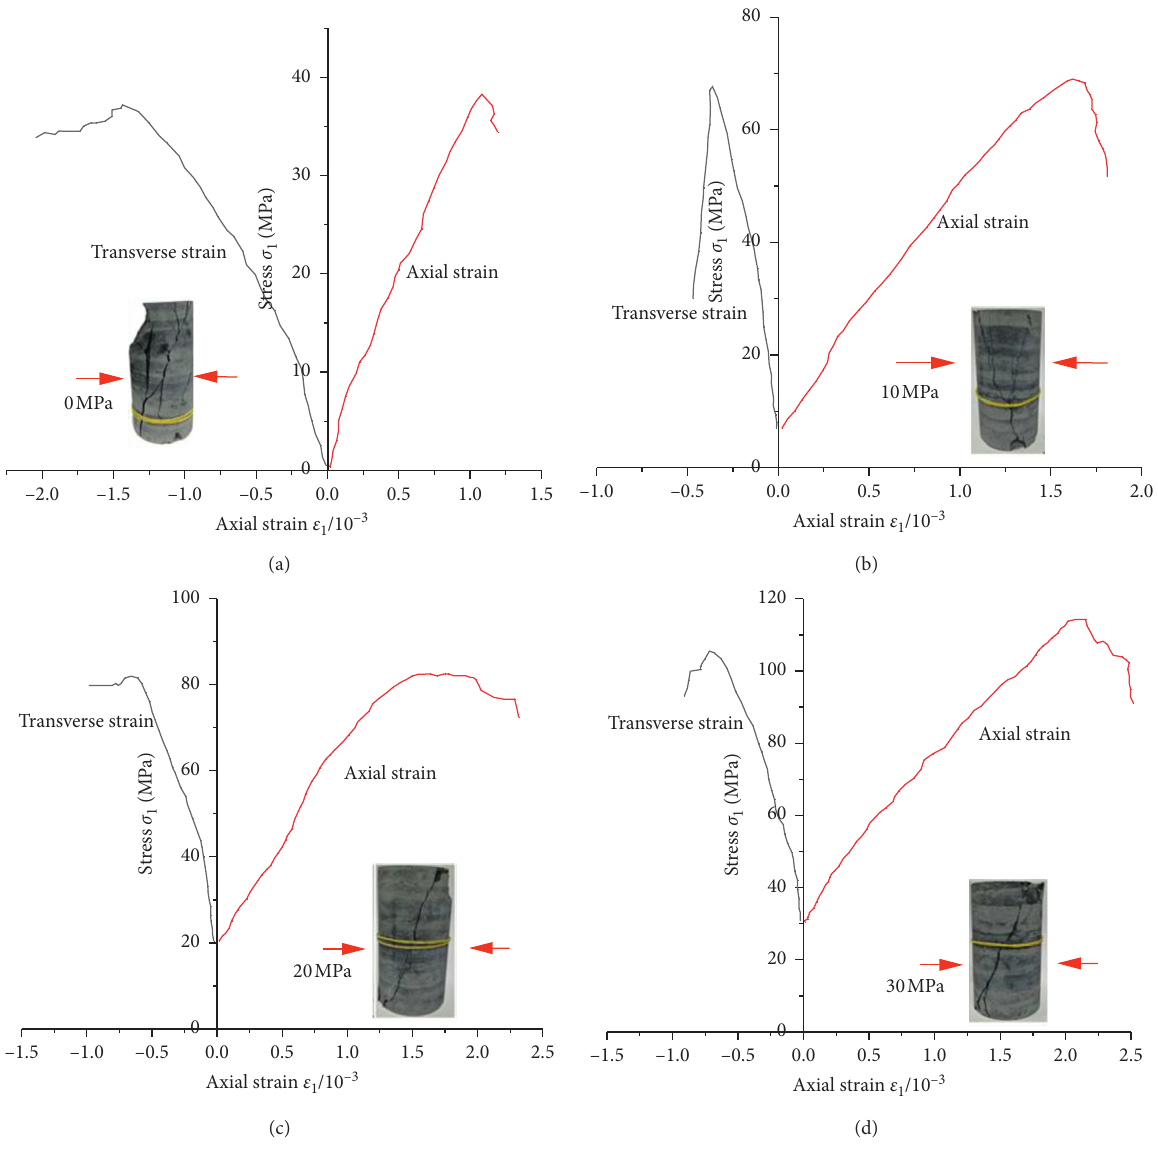
Figure 19: Stress-strain curves of slate on triaxial compression tests under different confining pressures: (a) 0 MPa, (b) 10MPa, (c) 20MPa, and (d)